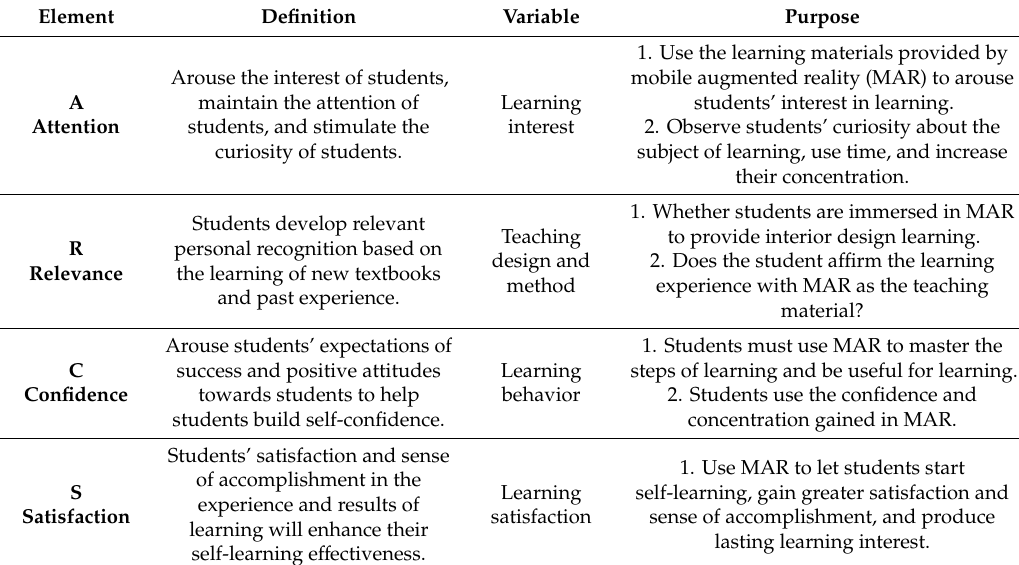
Table 1. Four elements and definitions of Attention, Relevance, Confidence, and Satisfaction (ARCS) model, following John Keller’s definitions